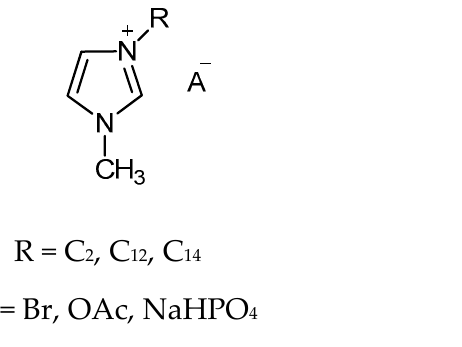
Figure 2. Ionic liquids used in study.